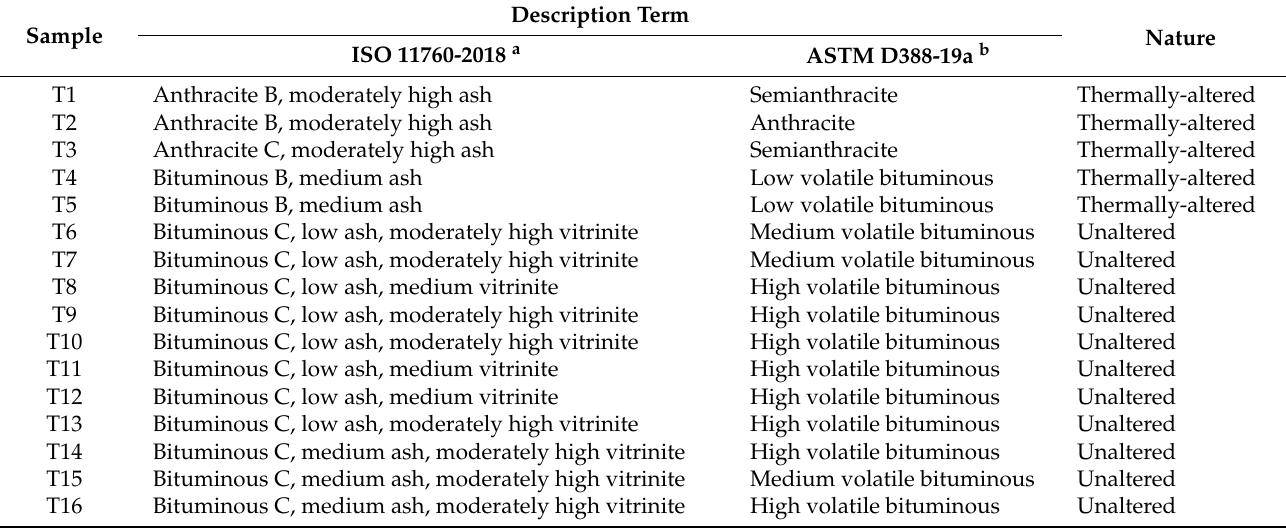
Table 4. Classification of the Tashan